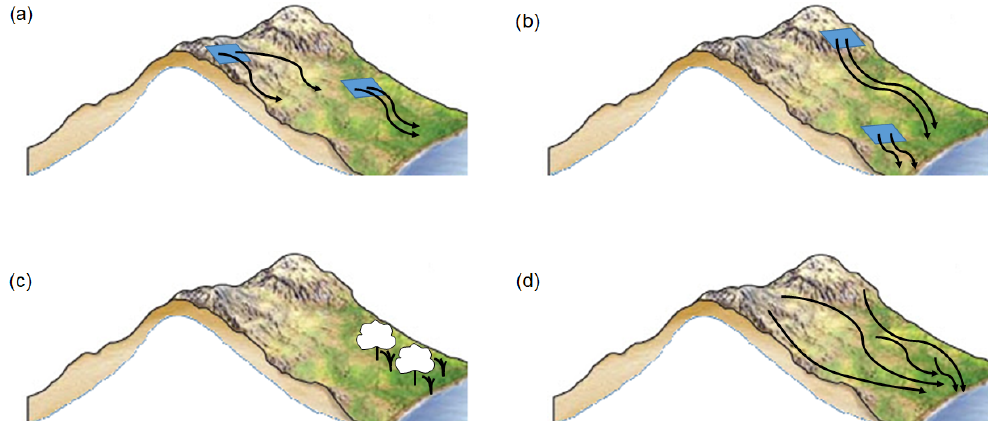
Figure A1. The raindrop analogy for the dynamical systems metrics. (a) Depending on the topography, raindrops falling on a small patch of ground on the side of a valley may follow similar paths (low local dimension) or different paths (high local dimension). (b) If the patch of ground is on a steep incline, the raindrops will leave it very rapidly (low persistence); if the incline is shallow, the raindrops will take longer to leave the patch (high persistence). (c, d) Vegetation will affect the raindrop paths, and at the same time the paths of the raindrops will affect the growth of the vegetation. Whenever the raindrops collectively follow similar paths, this will correspond to a recurring pattern of vegetation growth and vice versa (high co-recurrence ratio). Part of the figure has been excerpted from Marshak (2019), with permission of the publisher, W. W. Norton & Company, Inc. All rights reserved (Copyright © 2019, 2015, 2012, 2008, 2005, 2001 by W. W. Norton & Company, Inc.).